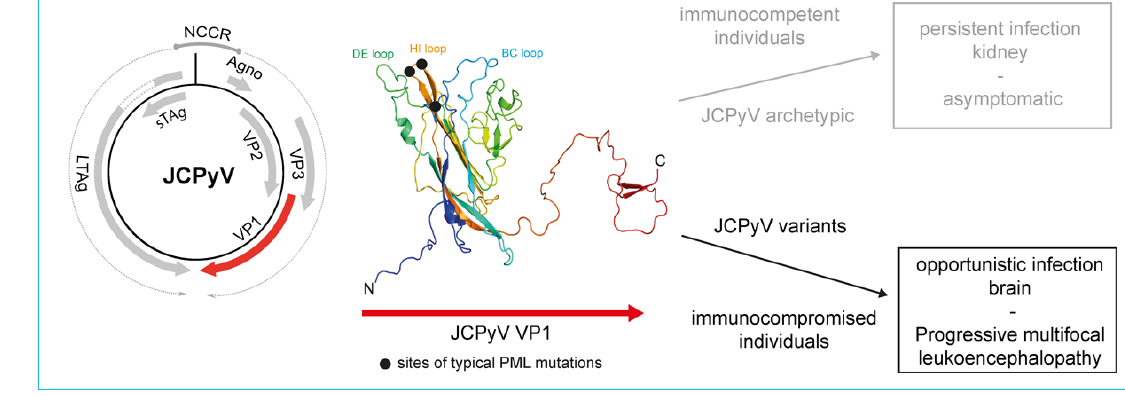
Figure 1: JCPyV and the development of PML. JCPyV encodes for six open reading frames under the control of the regulatory noncoding control region (NCCR) element. Mutations in the three exterior loops of the major capsid protein JCPyV VP1 may in situations of immunocom- promise lead to an opportunistic infection in the brain, known as